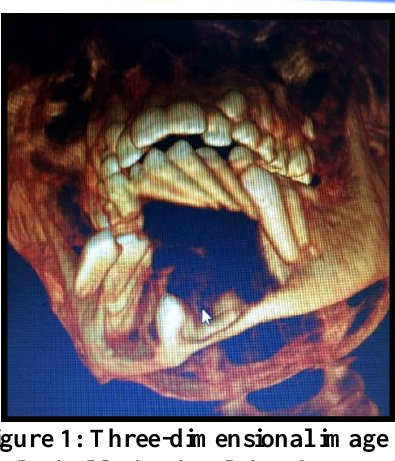
Figure 1: Three-dimensional image of pathological lesion involving the mandible with displacement of teeth and resorption of their roots, which was shown to be odontogenic keratocyst (OKC) with histopathological examination.